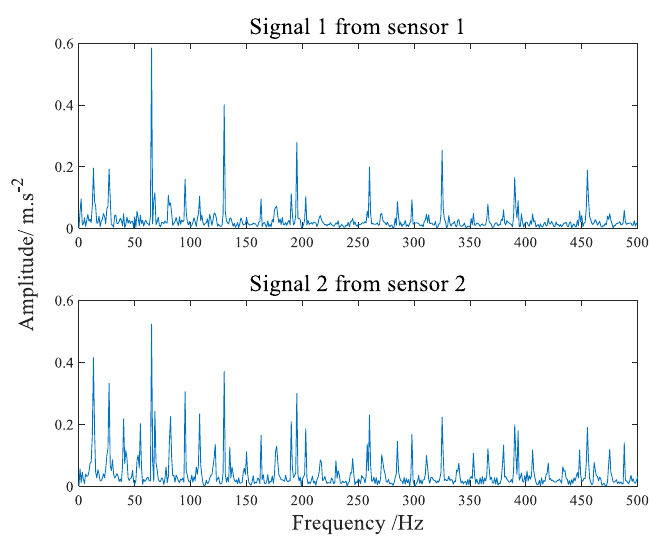
Figure 13. The envelope spectrum of composite fault signals.